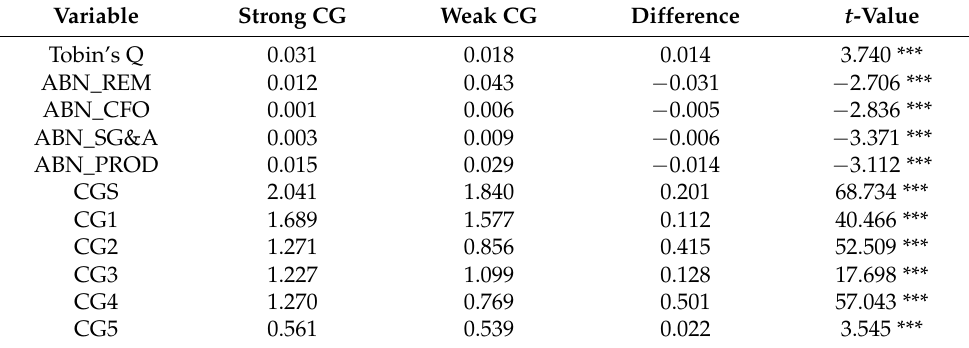
Table 6. t -test for equality of means for firms with strong CG vs. weak CG. Variable Strong CG Weak CG Difference t -Value Tobin’s Q 0.031